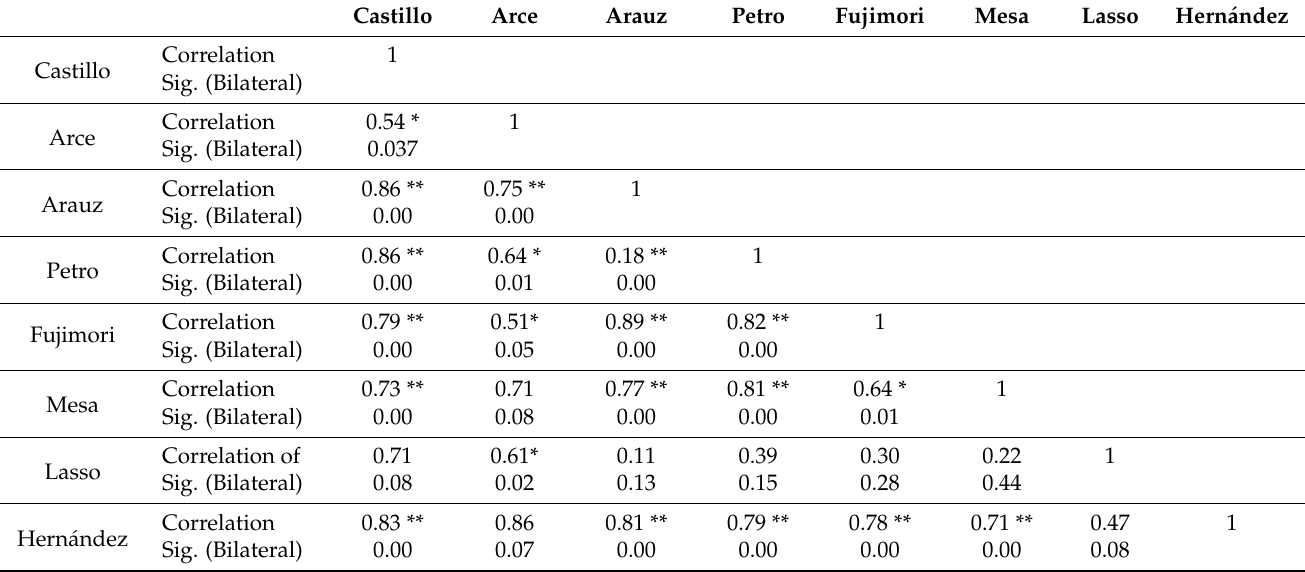
Table 6. Correlation (N = 18) using Pearson’s correlation